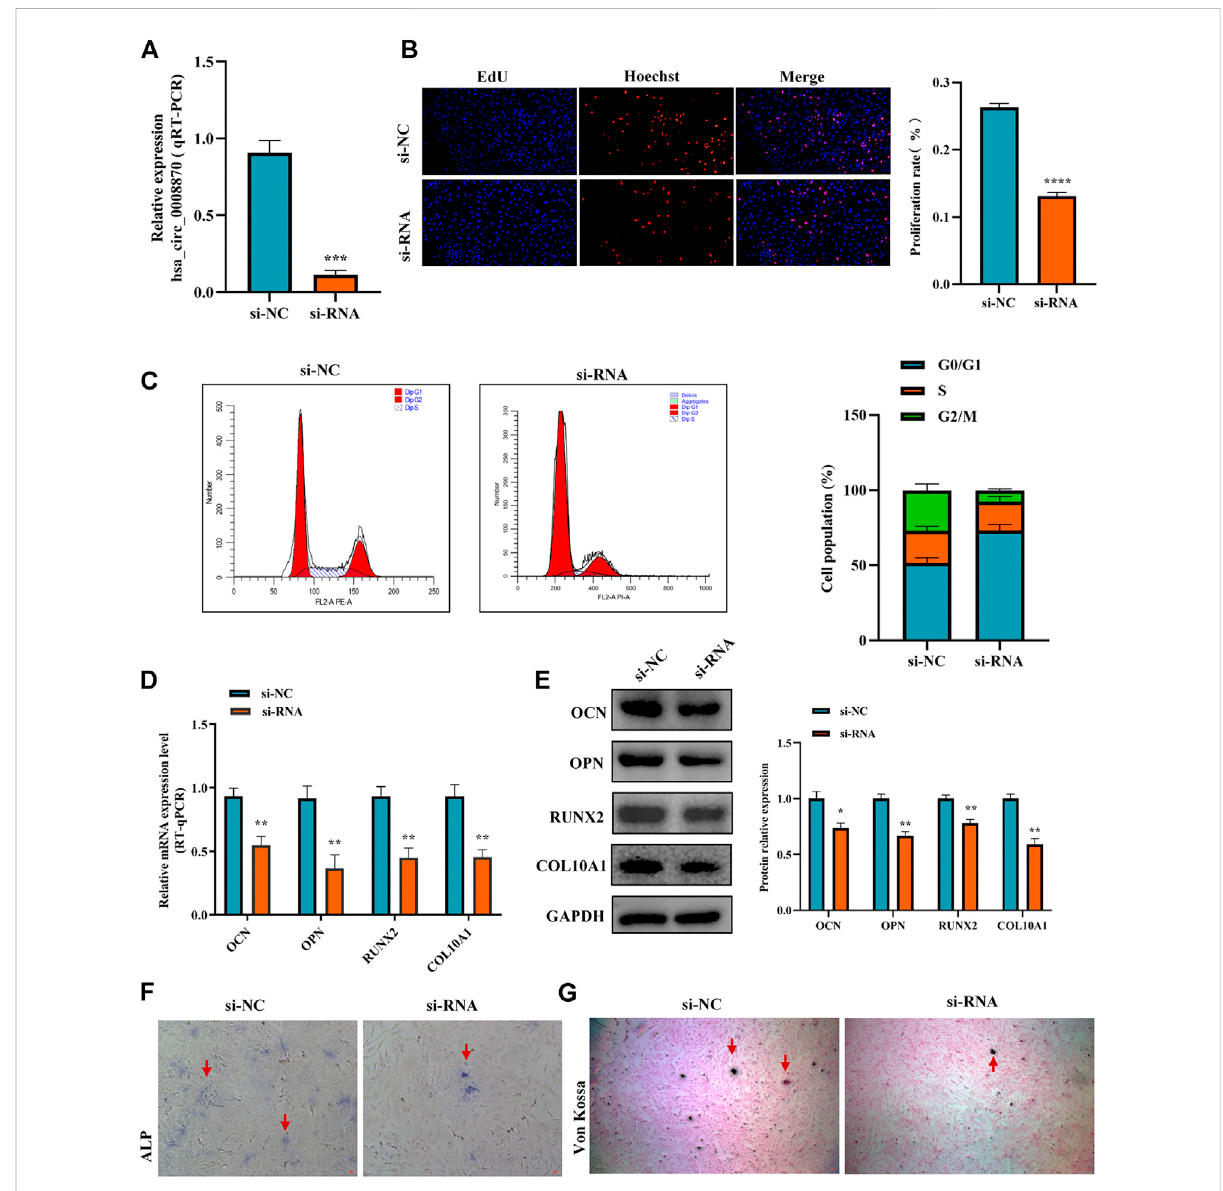
FIGURE 2 Silencing hsa_circ_0008870 inhibits chondrocyte proliferation, hypertrophy and endochondral ossi fi cation. (A) The expression of hsa_circ_0008870inchondrocytestransfectedwithsiRNAwasdetectedbyRT-qPCR. (B) Eduassayswasusedtodetectchangesincellproliferation afterknockdownofhsa_circ_0008870. (C) Flowcytometryassaysindicatechangesofcellcyclebyknockdownofhsa_circ_0008870. (D) Following knockdownofhsa_circ_0008870, themRNA expressions ofOCN, OPN, RUNX2 and collagentypeXweredetected by RT-qPCR. (E) Following knockdown of hsa_circ_0008870, the protein expression levels of OCN, OPN, RUNX2 and collagen type X were detected by Western blot. (F) The activity changes of ALP were observed following knockdown of hsa_circ_0008870. (G) Von Kossa staining demonstrated changes in mineralization after knockdown of hsa_circ_0008870. P > 0.05; *, p < 0.05; **, p < 0.01; ***, p < 0.001; ****, p <